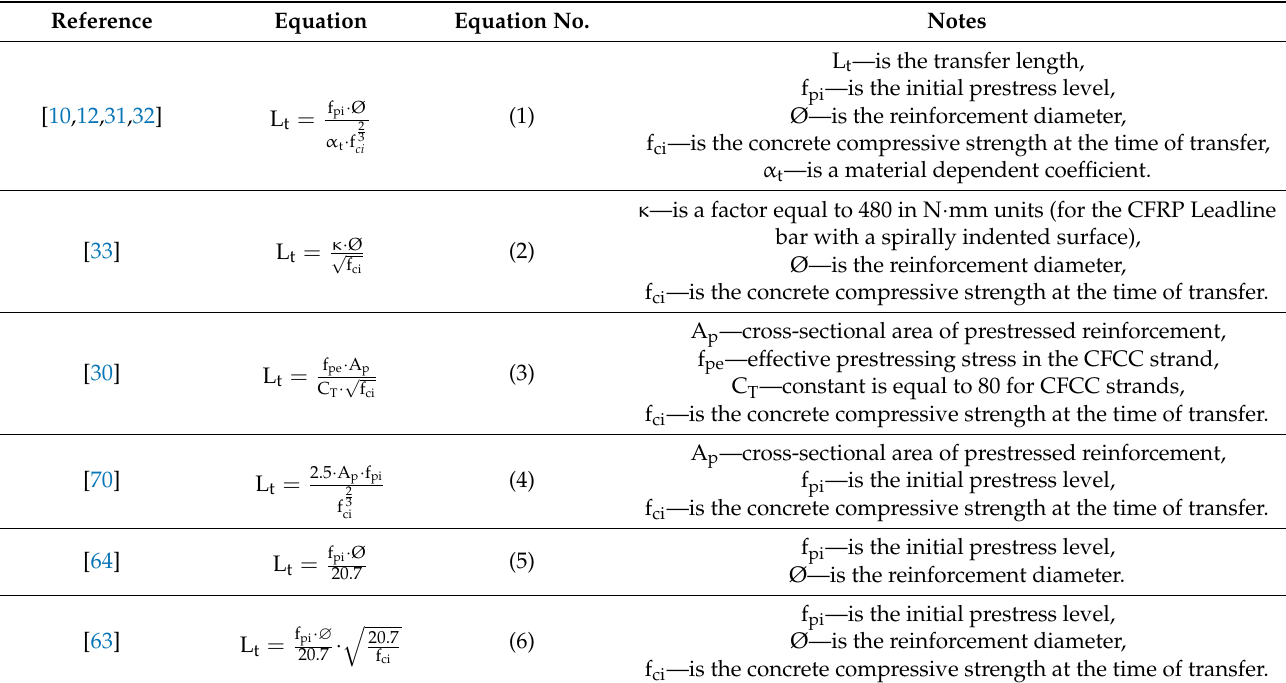
Table 8. Summary of the theoretical models for the transfer length of FRP